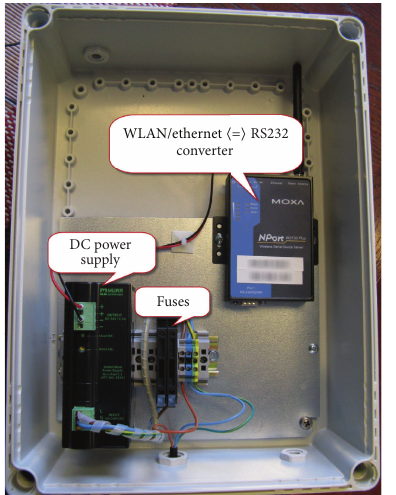
Figure 11: An information screen data transfer casing.